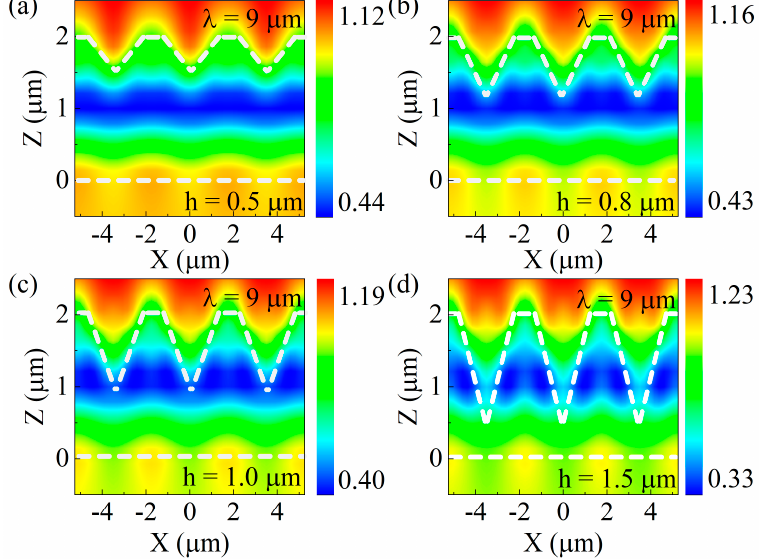
Figure 4. Simulated electric field intensity distributions for SQA with period of 3.5 µm and heights of ( a ) 0.5 µm, ( b ) 0.8 µm, ( c ) 1.0 µm, and ( d ) 1.5 µm in 9 µm wavelength.